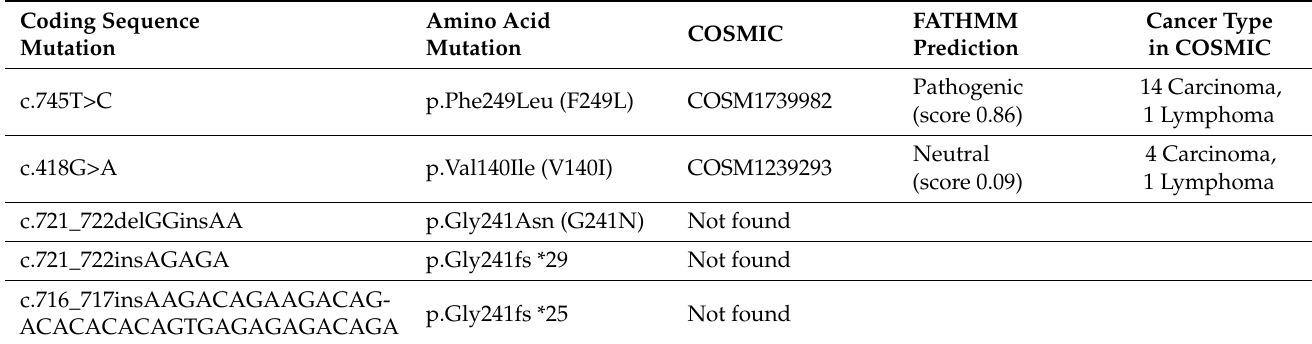
Table 3. Annotation of KRT6A variants in